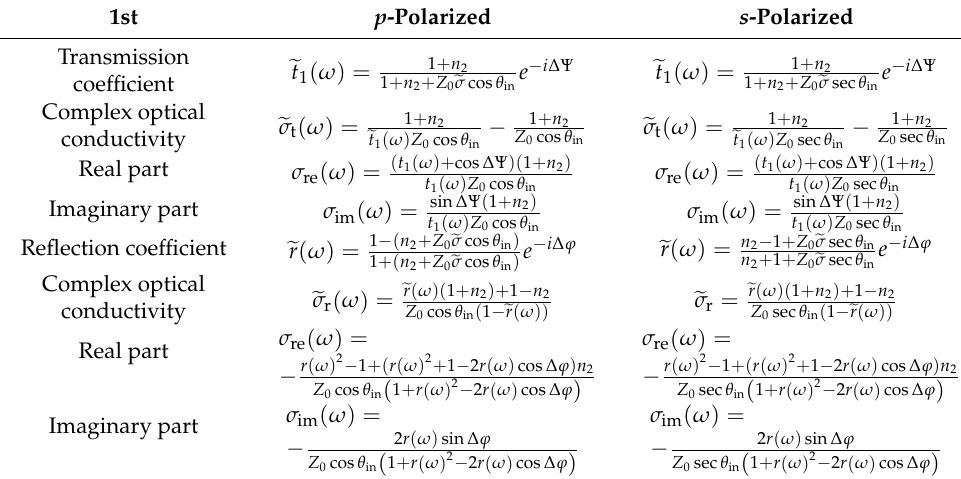
Table 2. The optical conductivity derived from the 1st-order transmission or reflection. 1st p